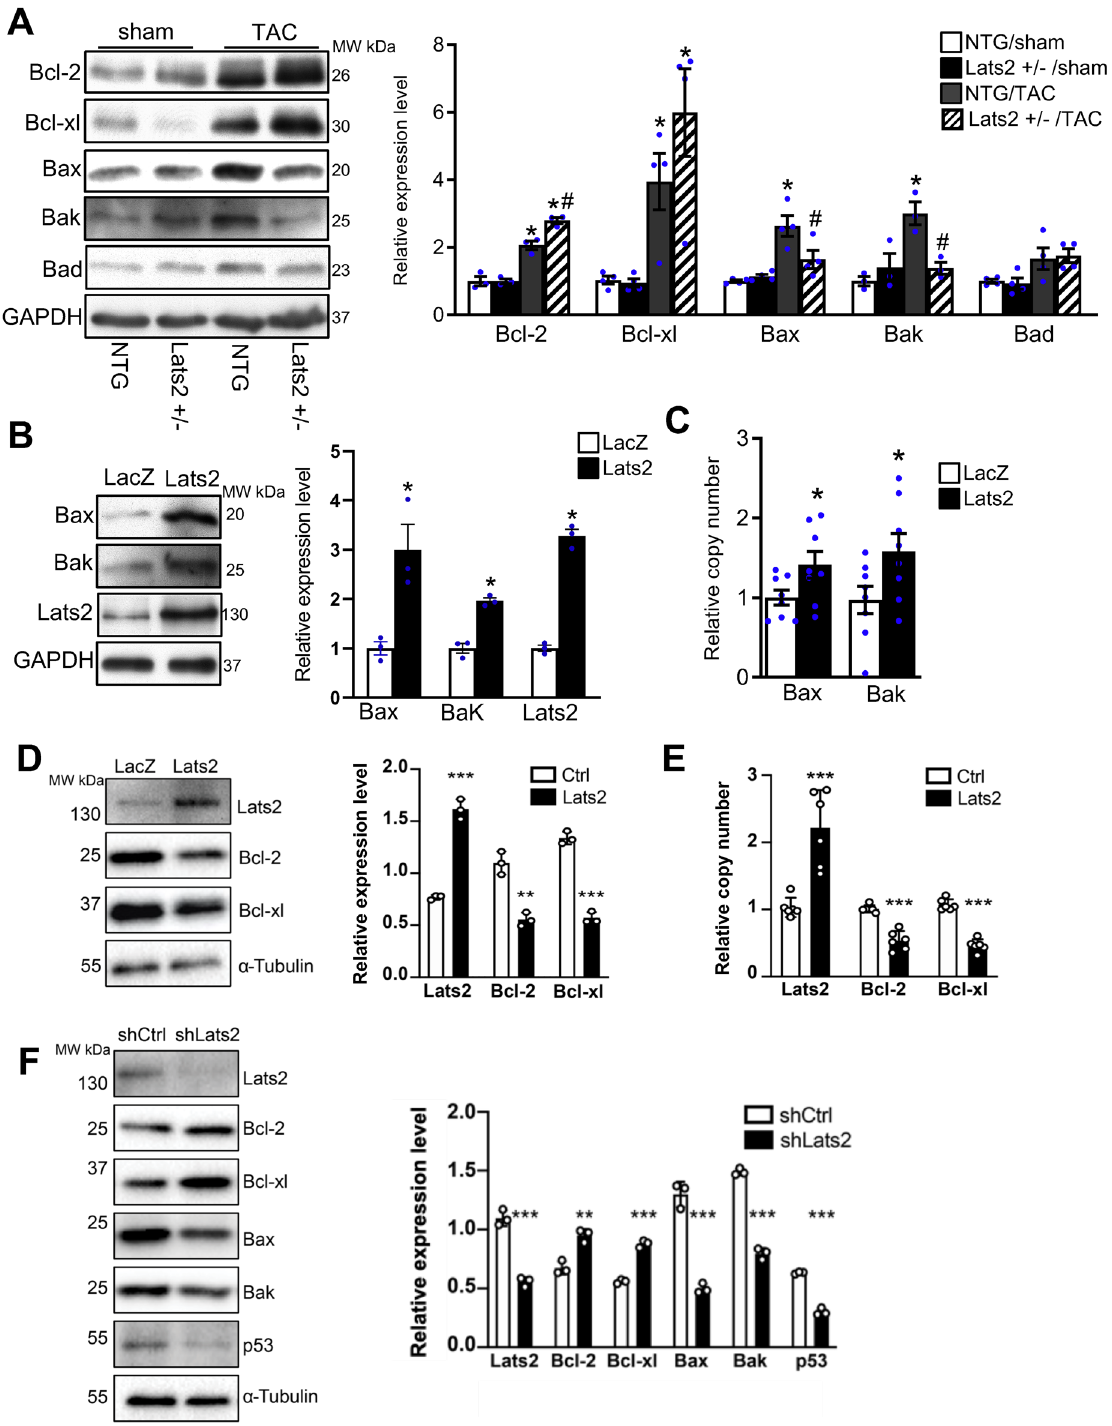
Figure 4. The role of Lats2 in mediating expression of Bcl-2 family proteins during pressure overload. ( A ), Non-transgenic (NTG) and Lats2 +/- mice were subjected to either transverse aortic constriction (TAC) or sham operation for 4 weeks. The levels of Bcl-2, Bcl-xL, Bax, Bak, Bad and GAPDH were evaluated with immunoblot analyses. Representative images (left) and quantification (right) are shown (n = 4). * p < 0.05 versus NTG mouse hearts with sham operation. # p < 0.05 versus NTG mouse heart with TAC for 4 weeks. ( B – E ), Cultured neonatal rat ventricular cardiomyocytes were transduced with adenovirus harboring LacZ or Lats2. B, The levels of Bax, Bak, Lats2 and GAPDH were evaluated with immunoblot analyses. Representative images (left) and quantification (right) are shown (n = 4). ( C ), mRNA levels of Bax and Bak were evaluated with qPCR analyses. * p < 0.05 versus Adenovirus harboring LacZ. ( D ), The levels of Bax, Bak, Lats2 and α-Tubulin were evaluated with immunoblot analyses. Representative images (left) and quantification (right) are shown. (n = 3). ( E ), mRNA levels of Bax and Bak were evaluated with qPCR analyses. (n = 6). * p < 0.05, ** p < 0.01, *** p < 0.001 versus Adenovirus harboring LacZ. ( F ), Cultured neonatal rat ventricular cardiomyocytes were transduced with adenovirus harboring shRNA Lats2 or shRNA control. The levels of Lats2, Bcl-2, Bcl-xL, Bax, Bak, p53 and α-tubulin were evaluated with immunoblot analyses. Representative images (left) and quantification (right) are shown (n = 3). * p < 0.05, ** p < 0.01, *** p < 0.001 versus Adenovirus harboring shRNA